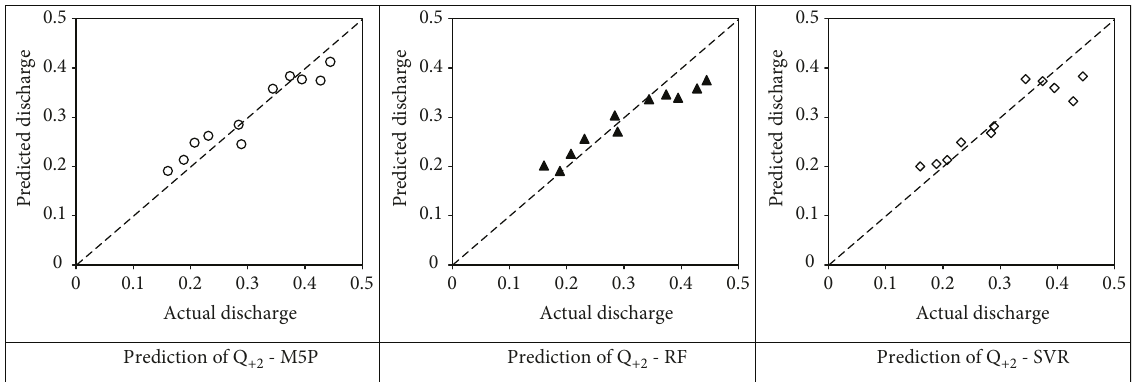
Figure 11: Comparison between predicted and observed discharges (m 3 /s), 4-month input.